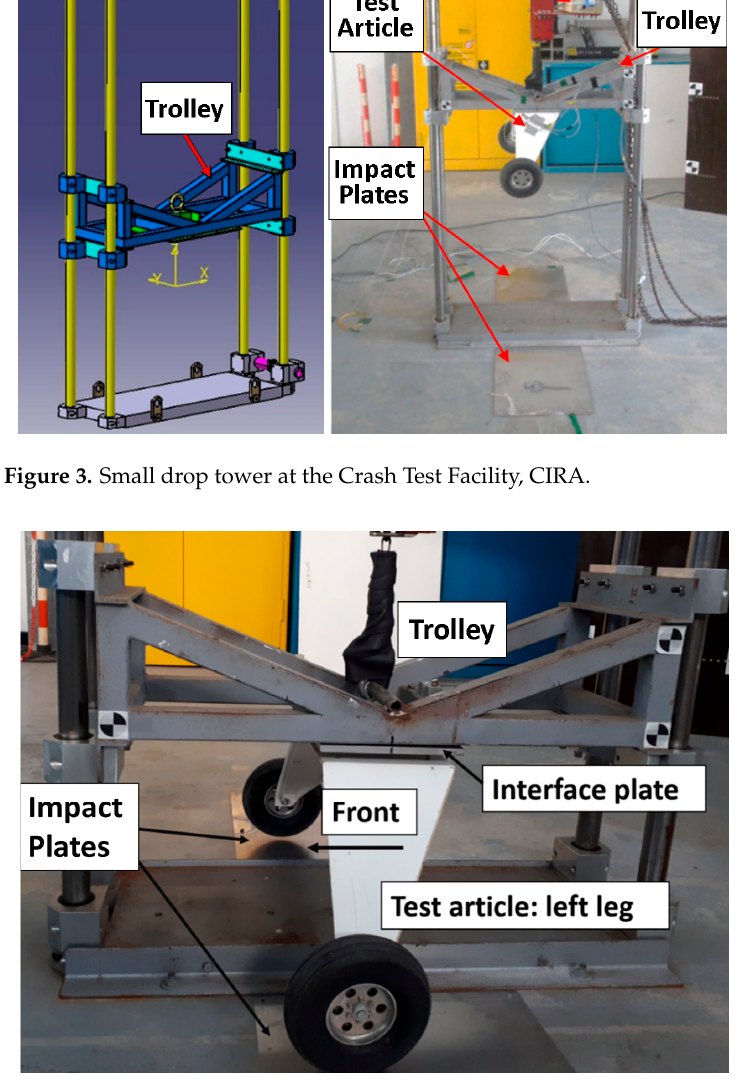
Figure 4. Test article/interface plate/trolley system, as it touches the two impact plates mounted on the ground.